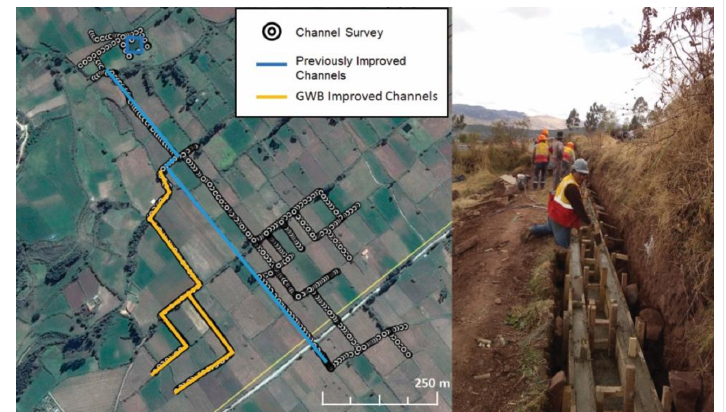
Figure 7. The left panel shows the area of canal improvements (green-shaded area of Figure 4). Circles show the extent of the irrigation canal network, with the blue square indicating the location of a surface reservoir that regulates flow to the canals. The blue line shows canals constructed by the community prior to 2018. The yellow line shows the extent of the 1.3 km of canals built through the Geoscientists Without Borders-funded Bonanza collaboration with the community of Zurite. The entire project totaled USD 71,283 and GWB’s contribution was USD 20,000. The photograph on the right shows the early phases of construction in fall